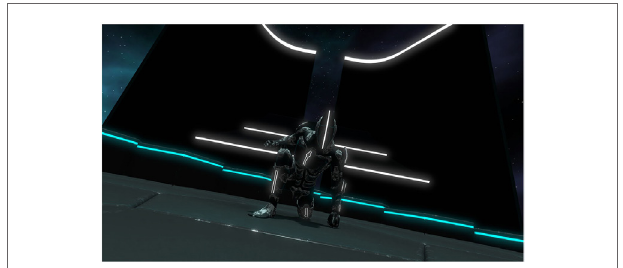
FigUre 1 | In-game content of the virtual reality application developed for the experiment.